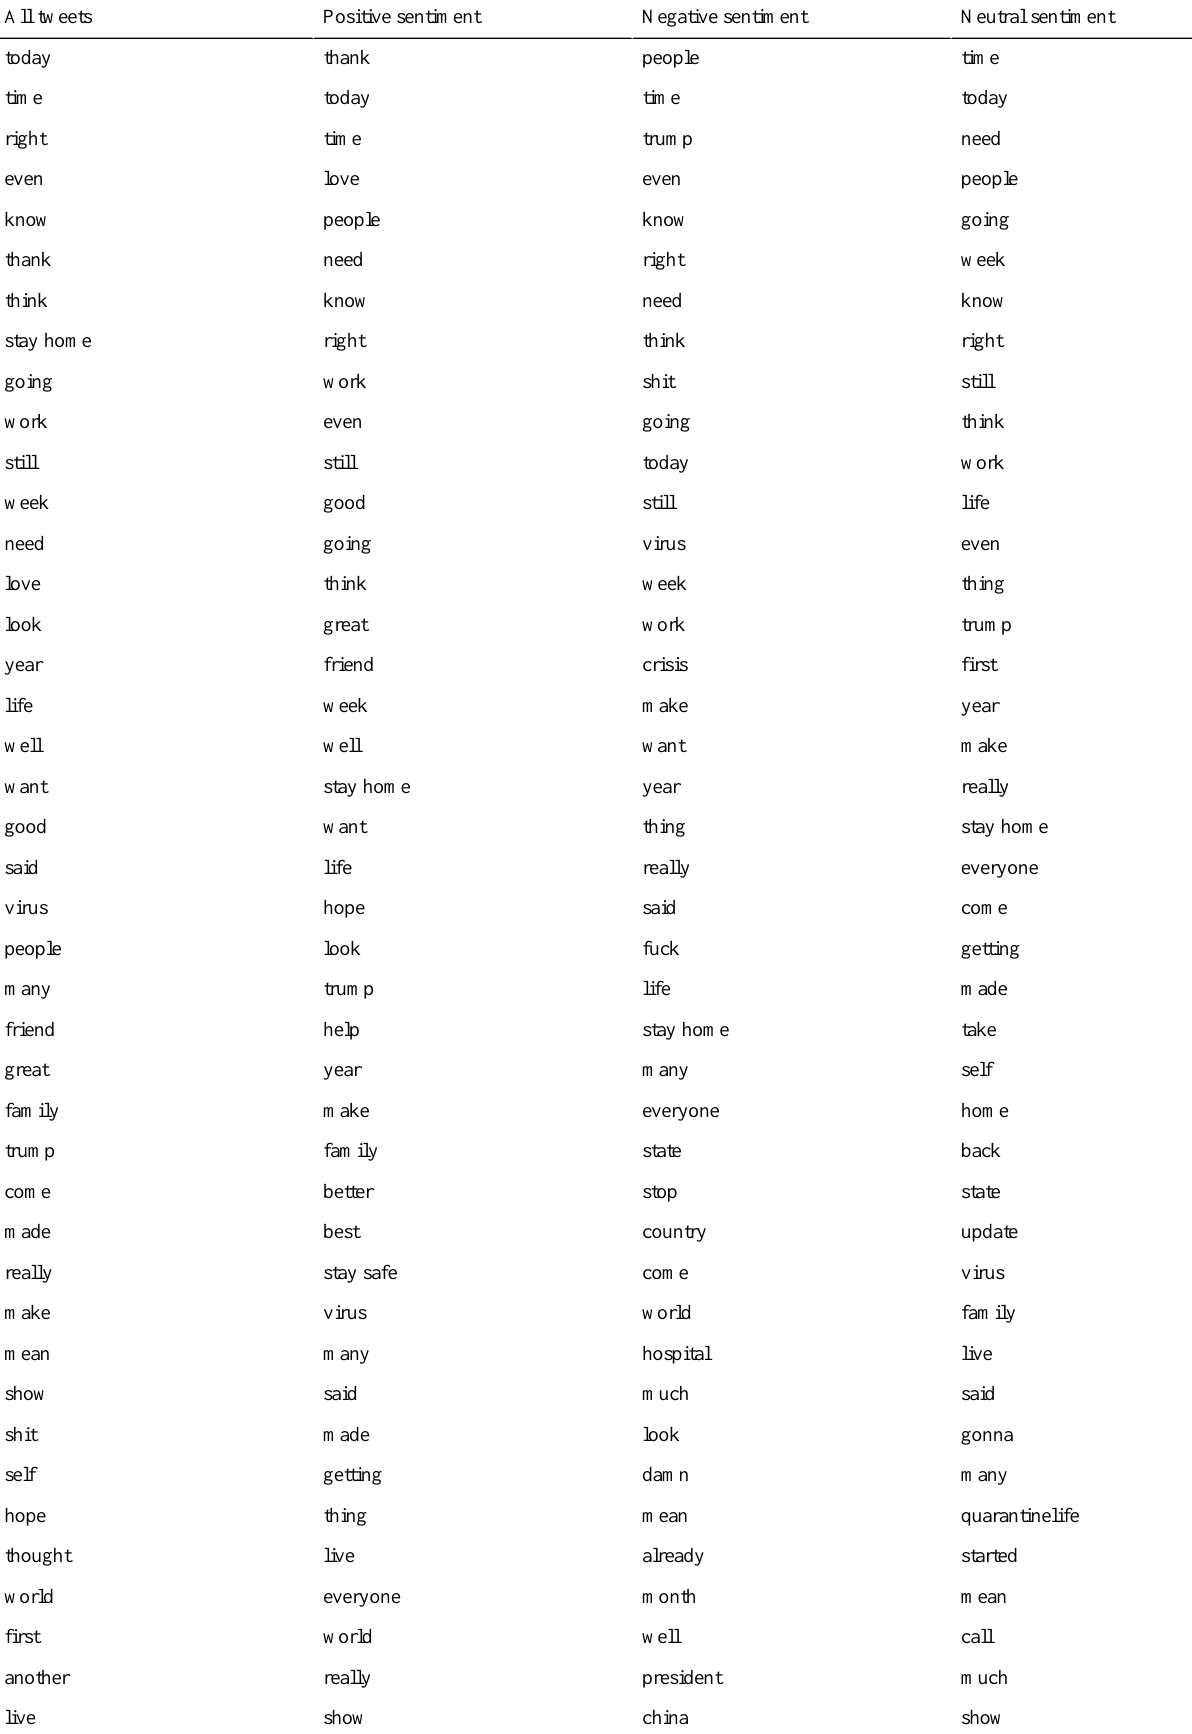
Table 2. The most frequently used word stems across Twitter users’post descriptions related to coronavirus disease (COVID-19) by